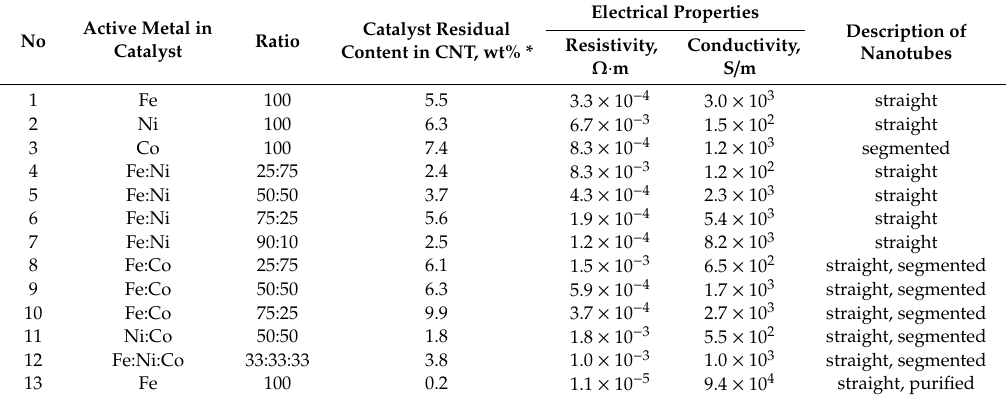
Electrophysical and structural characterization of the nanotubes synthesized with di ff erent